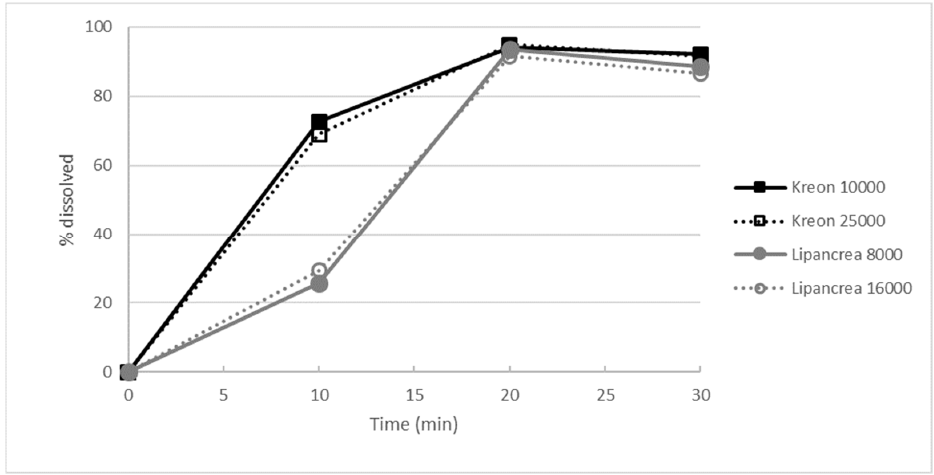
Figure 4. Dissolution profile in phosphate buffer at pH 6.0, as evaluated by the percentage of lipase activity released.